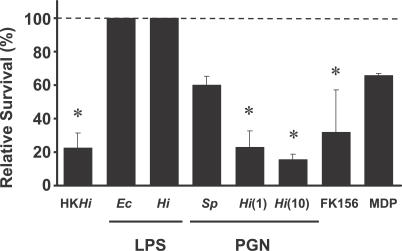
The Ability of Bacterial Components to Stimulate Opsonophagocytic Killing of Sp
Neutrophil-enriched PECs were obtained from C57Bl/6 mice pretreated by i.p. administration of casein containing heat-inactivated whole Hi636 (HKHi, n = 6), E. coli LPS (50 μg/animal, n = 3), Hi LPS (50 μg/animal, n = 4), Sp peptidoglycan (PGN, 10 μg/animal, n = 5), Hi peptidoglycan (PGN, 1.0 or 10 μg/animal, n = 4 and 3, respectively), FK-156 (1.0 μg/animal, n = 6), or MDP (10 μg/animal, n = 3). Survival of Sp1121 is shown relative to controls where neutrophil-enriched PECs were elicited by casein administration alone. Values represent duplicate determinations of the number of independent experiments indicated above for each condition ± SD. *p < 0.01 compared to casein alone control.